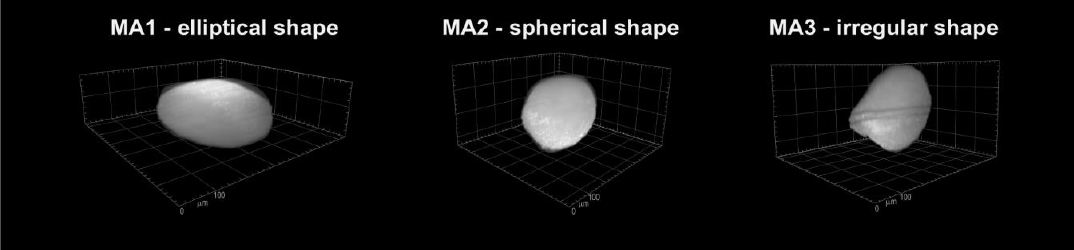
Figure 2. 3D representation of the multicellular aggregates considered in this work. ( a ) Multicellular Aggregate 1 (MA1), characterised by an elliptical shape; ( b ) MA2, spherical shaped, practically, a spheroid ; ( c ) MA3, irregular shaped. Images obtained with software Zeiss ZEN version 2.3 Blue Edition.